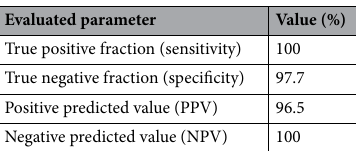
Table 2. Performance parameters of the LAMP assay